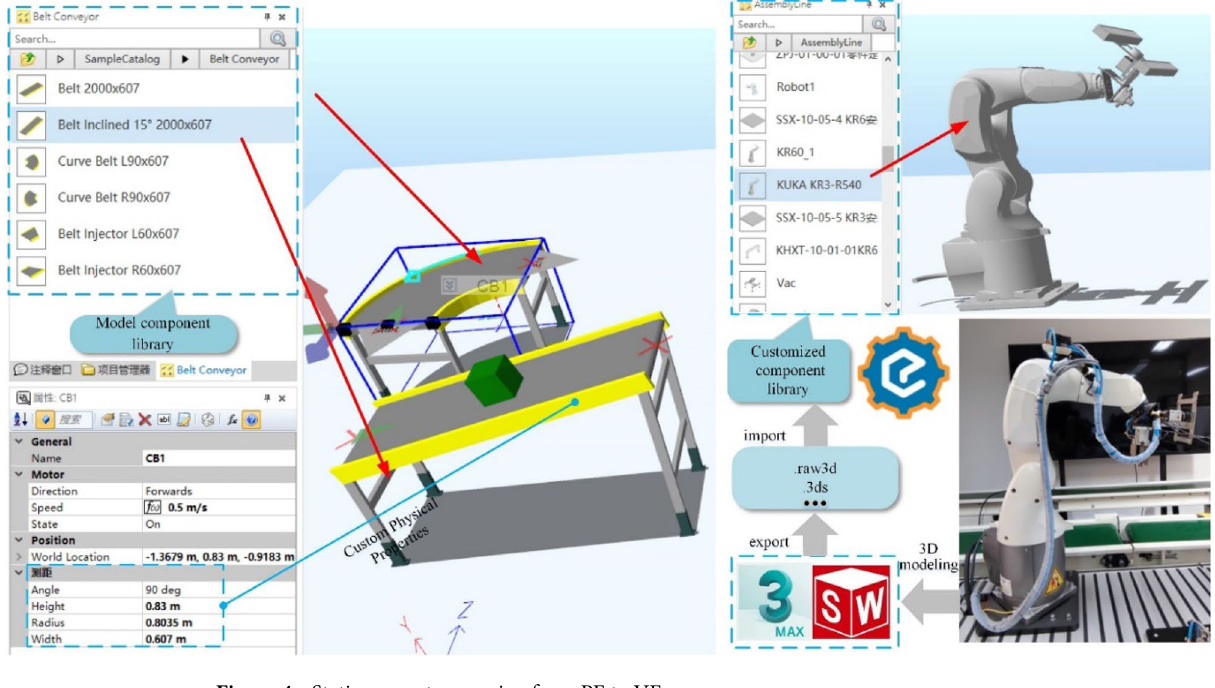
Figure 4. Static property mapping from PE to VE.